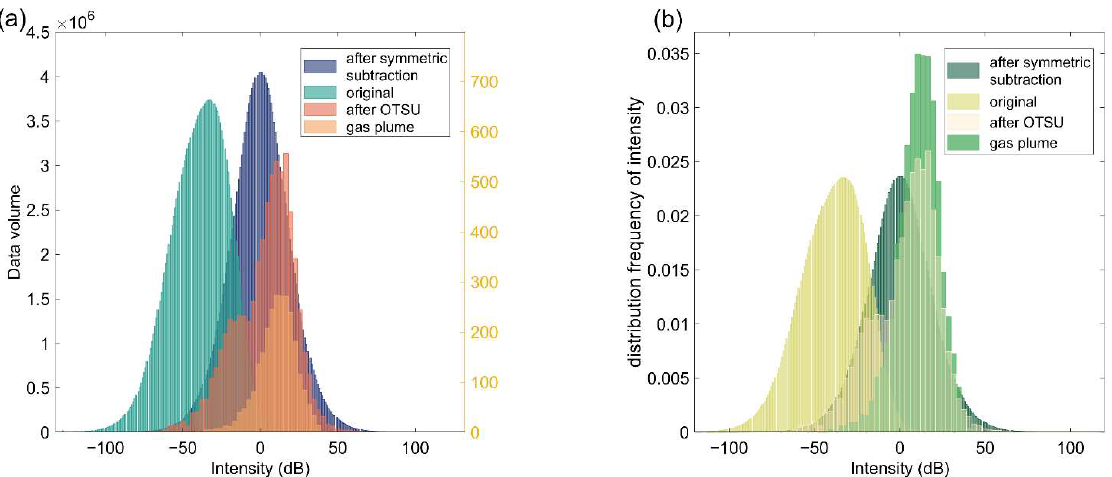
Figure 16. Histogram of the reflection intensity and distribution frequency of MWC data at different stages of the algorithm. ( a ) shows the backscattering intensity of MWC. The sampling point of the backscattering intensity of the original MWC and MWC after subtraction has a large amount of data (left axis) while the backscattering intensity of the MWC plume after the Otsu algorithm has a large amount of data (right axis); ( b ) shows the frequency of the different backscattered intensity distributions of the MWC at each stage of the algorithm.